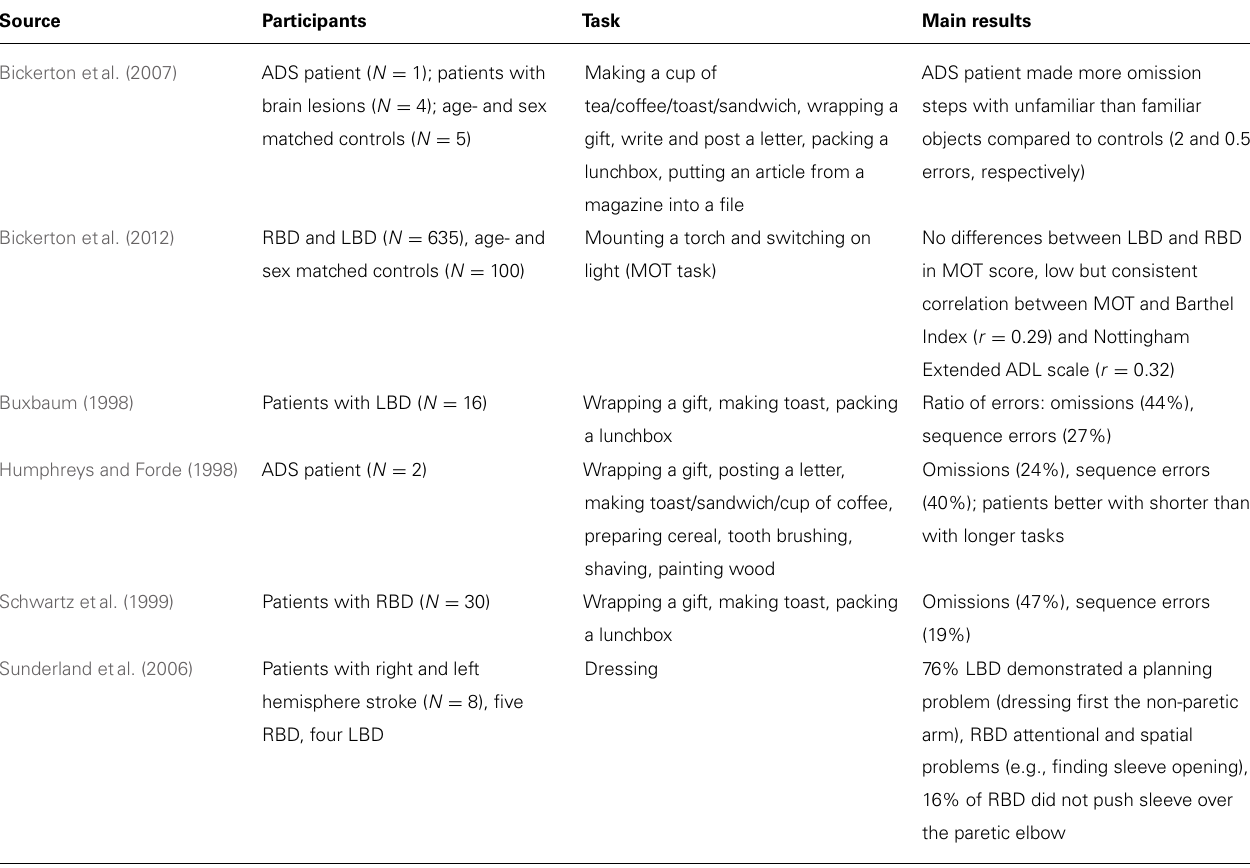
Table 1 | Summary of studies on sequencing errors related to theADL inAADS.